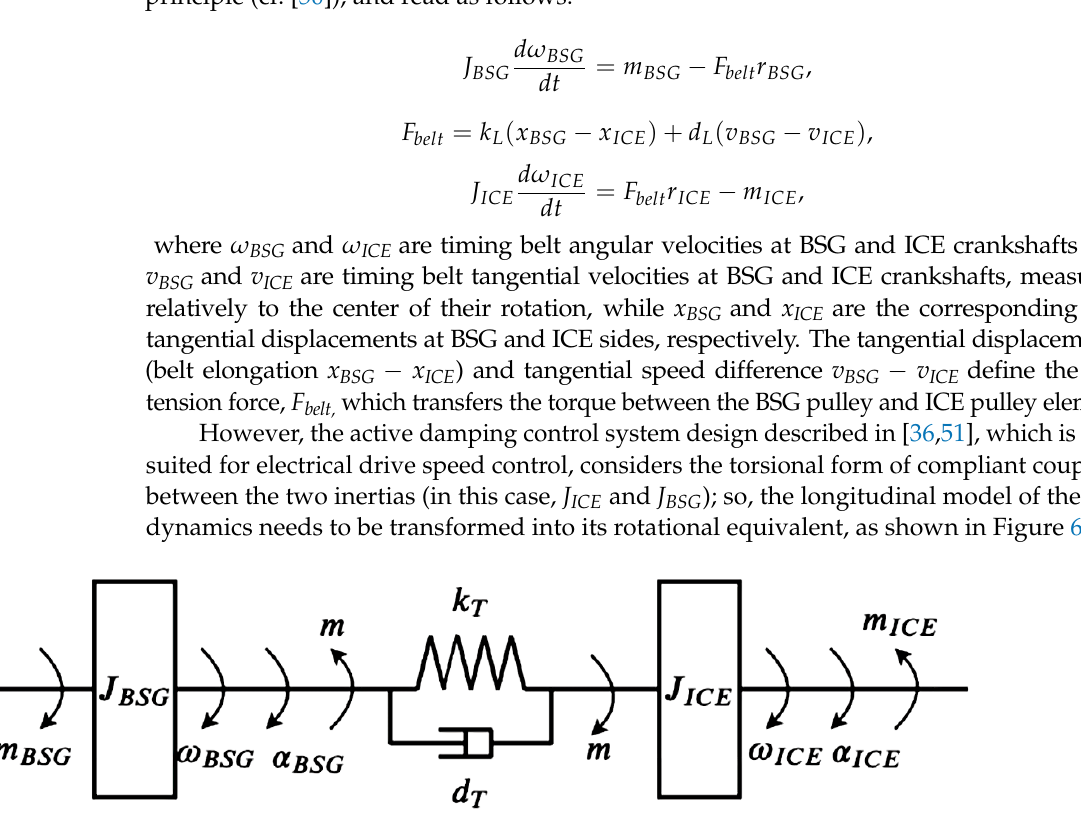
Figure 6. FEAD model with belt drive longitudinal dynamics and its corresponding rotational equivalent [10].